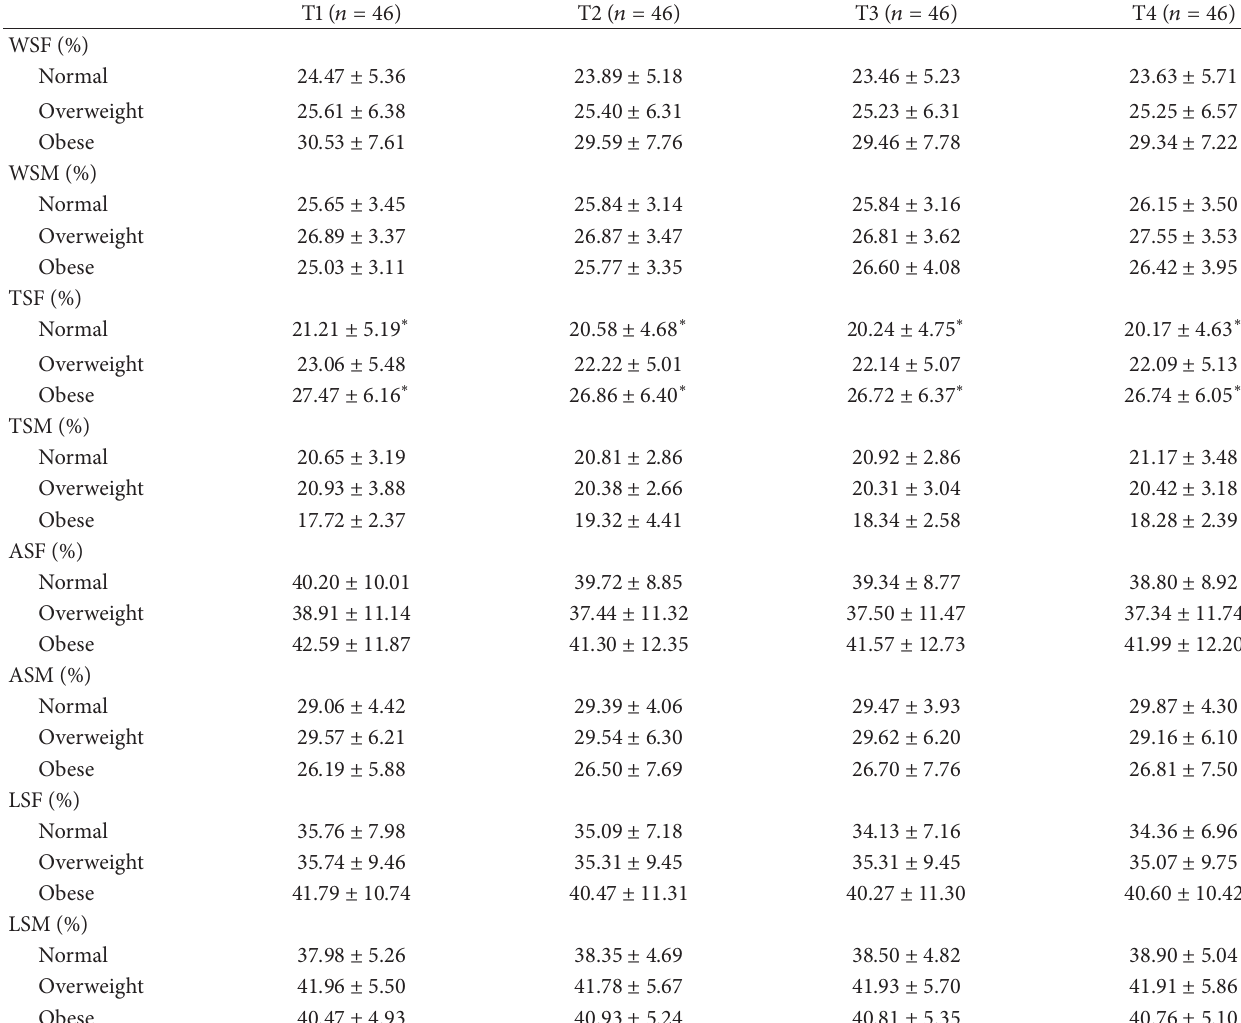
Table 2: Body composition status in subjects with different weight